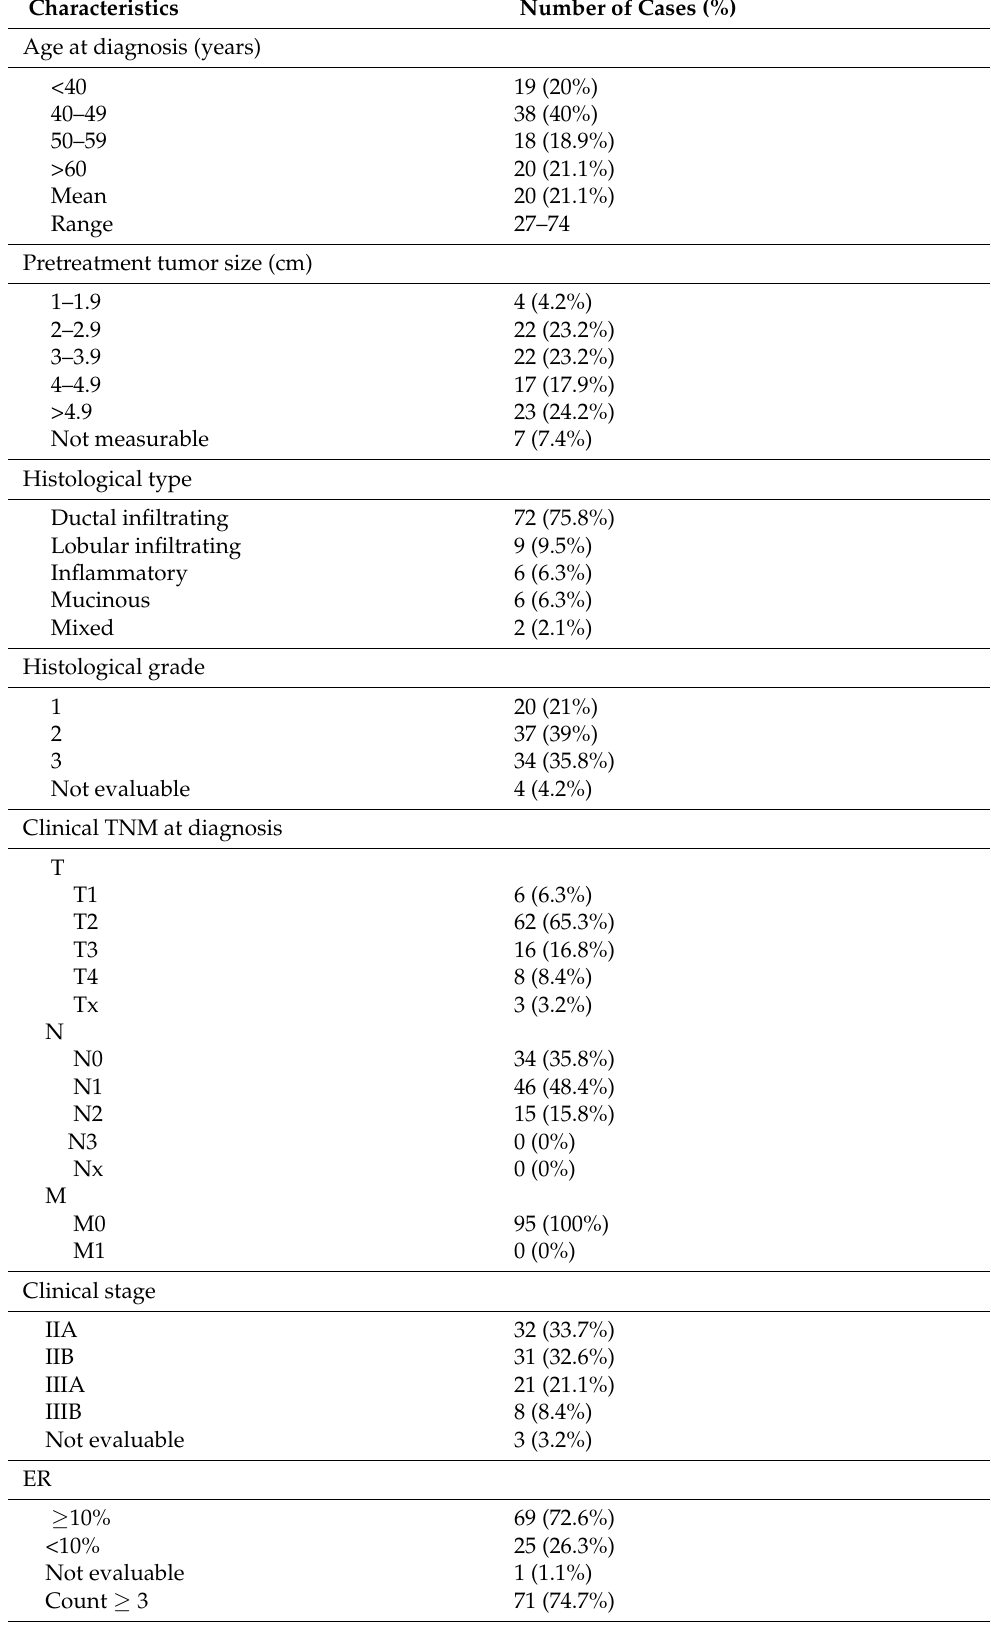
Table 1. Clinicopathologic characteristics of